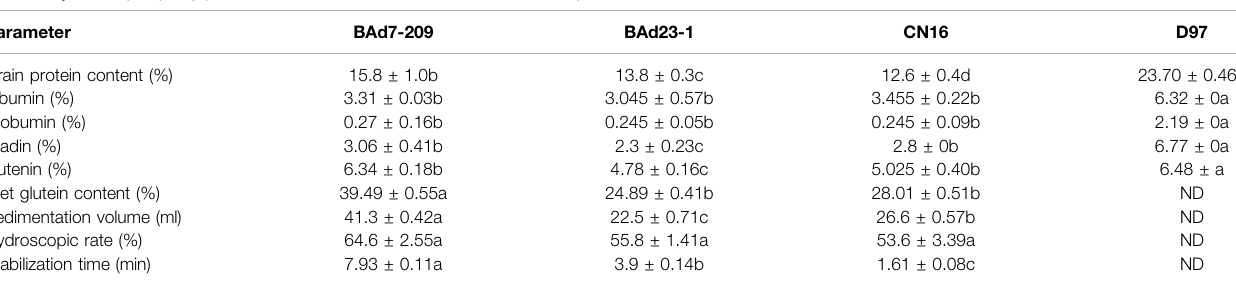
TABLE 2 | The major quality parameters in BAd7-209 and BAd23-1 and their parents.